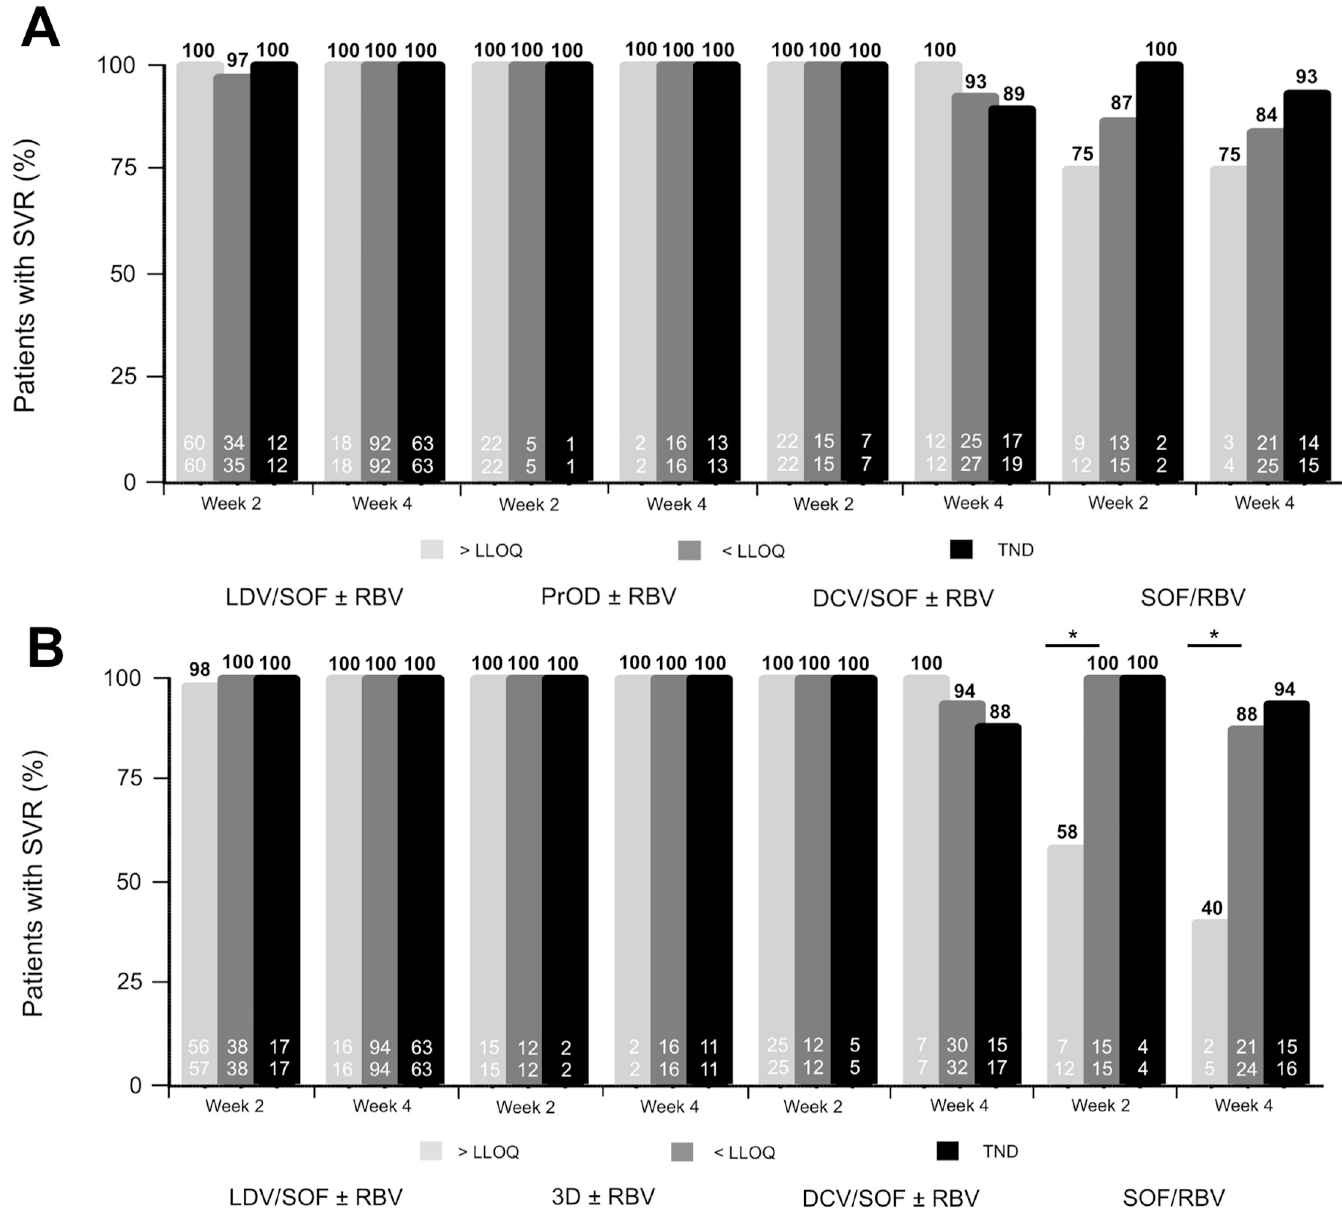
Fig 3. Sustained virologic response (SVR) rates according to early HCV RNA response at treatment week 2 and week 4 with different DAA regimens assessed with (A) cobas HCV and (B) CAP/CTM. SVR rates were not significantly different between patients with quantifiable ( � LLOQ) vs. non-quantifiable ( < LLOQ and TND) and detectable ( � LLOQ and < LLOQ) vs. undetectable (TND) HCV RNA in the three most commonly used DAA regimens (LDV/SOF, PrOD, DCV/SOF) according to both assays. SVR rates in patients with quantifiable ( � LLOQ) vs. non-quantifiable ( < LLOQ and TND) in the SOF/RBV treatment group showed significant difference at week 2 (p = 0.01) and week 4 (p < 0.05) when applying CAP/CTM but not with cobas HCV.